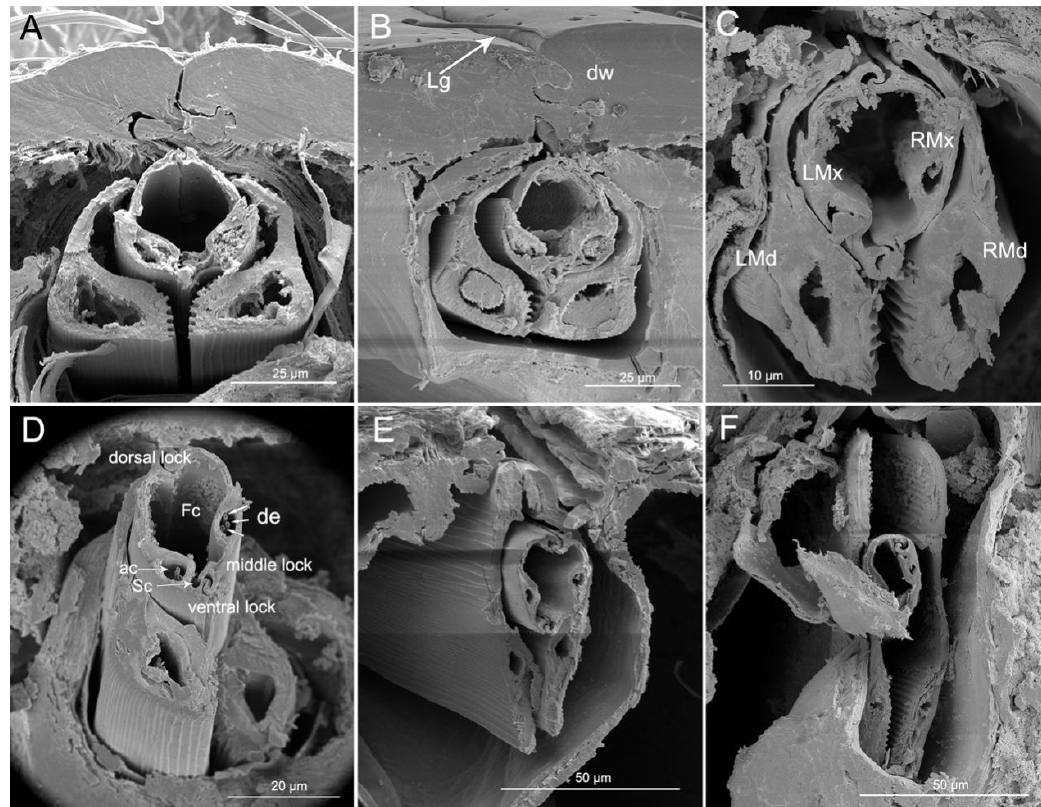
Figure 11. Cross-sections of stylet fascicle and labium of Haematoloecha nigrorufa. A . Proximal part of labial segment; B . Median part of segment 2; C . Junction of segments 2 and 3; D . Junction of segments 2 and 3 showing dendrites; E . Median part of segment 3; F . Junction of segments 3 and 4; LMd, left mandibular stylet; LMx, left maxillary stylet; RMd, right mandibular stylet; RMx, right maxillary stylet; Fc, food canal; Sc, salivary canal; de, dendrite; ac, axial canal; Lg, labial groove; dw, dorsal wall.